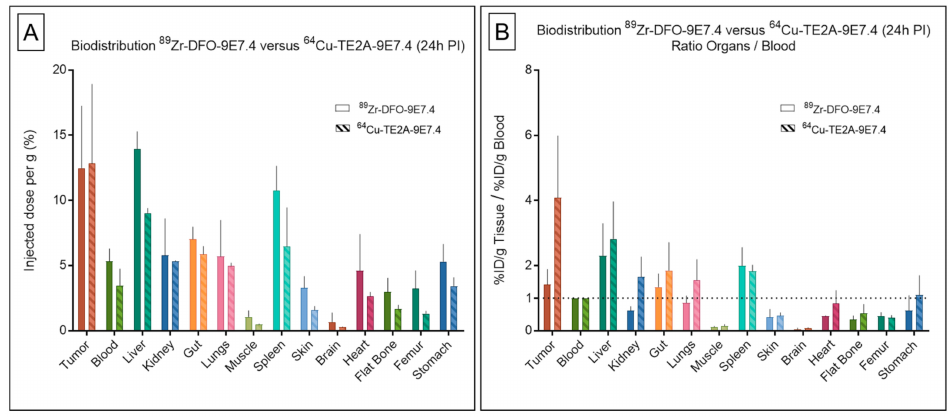
Figure 8. Biodistribution results and organ-to-blood ratios of 89 Zr-DFO-9E7.4 and 64 Cu-TE2A-9E7.4 in tumor-bearing mice. Ex vivo biodistribution results ( A ) and organ-to-blood ratios ( B ) of 64 Cu-TE2A-9E7.4 and 89 Zr-DFO-9E7.4 at 24 h post-injection (PI) in the subcutaneous tumor model ( n = 3 for each group). Values are expressed in percentage of the injected radioactive dose per gram of tissue (%ID / g) and presented as mean ±